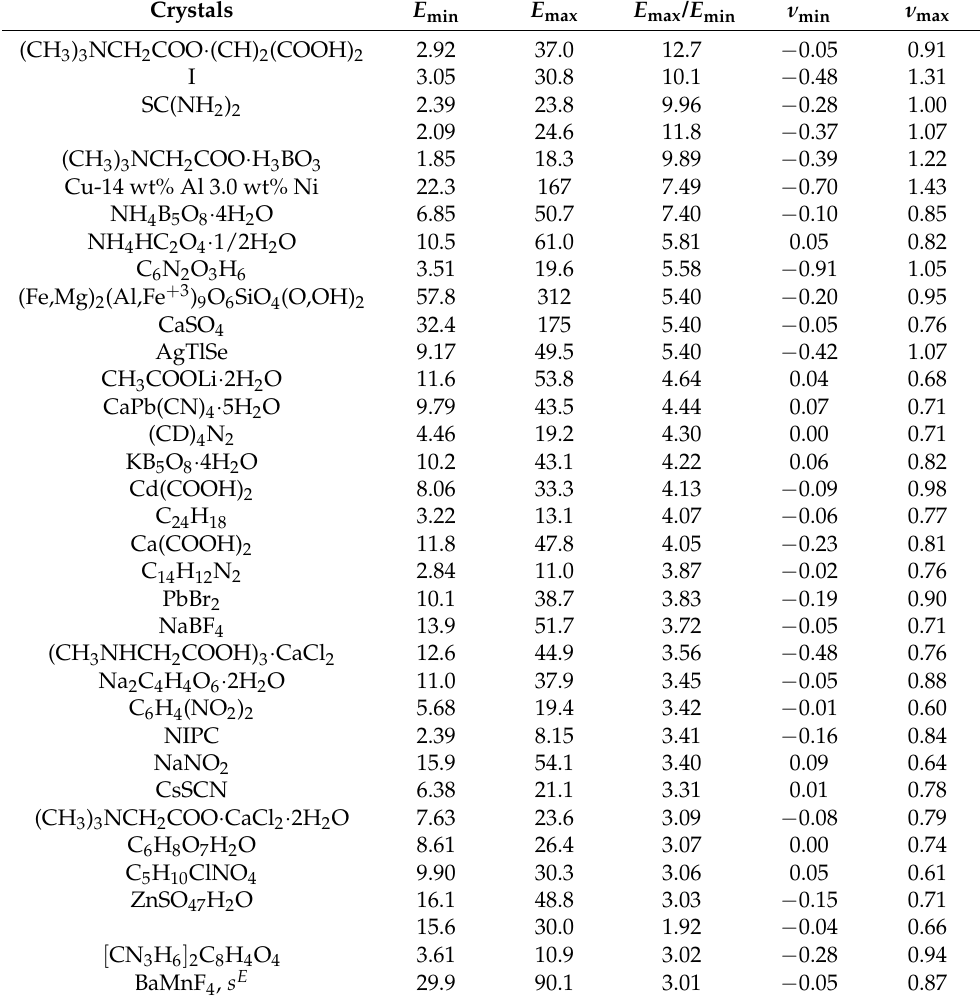
Table 3. The values of the minimum and maximum Young’s moduli E min , E max and their ratios, E max / E min ; and the values of the minimum and maximum Poisson’s ratios, ν min and ν max .